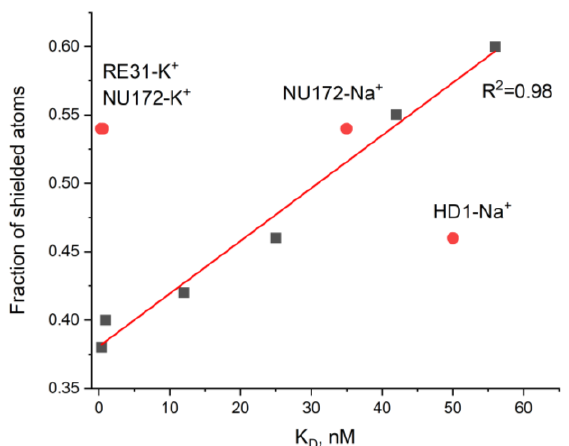
Figure 2. The correlation between dissociation constants (K D ) and the fractions of shielded atoms in the non-polar core of the aptamer-recognizing loops. Black squares are thrombin complexes of HD1-like 15-nucleotide-long aptamers coordinated by K + ; these data were fitted with a linear dependence (R 2 = 0.98). Other aptamer – thrombin complexes are shown in red, including two aptamers coordinated by Na + and two aptamers with the additional duplex modules.